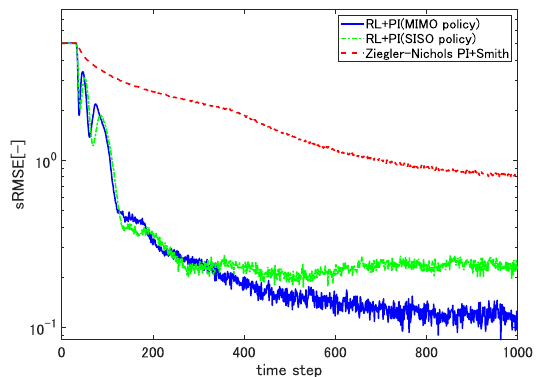
Figure 14. Change in the sRMSE metric for the perturbation of the plant in the 41st episode.